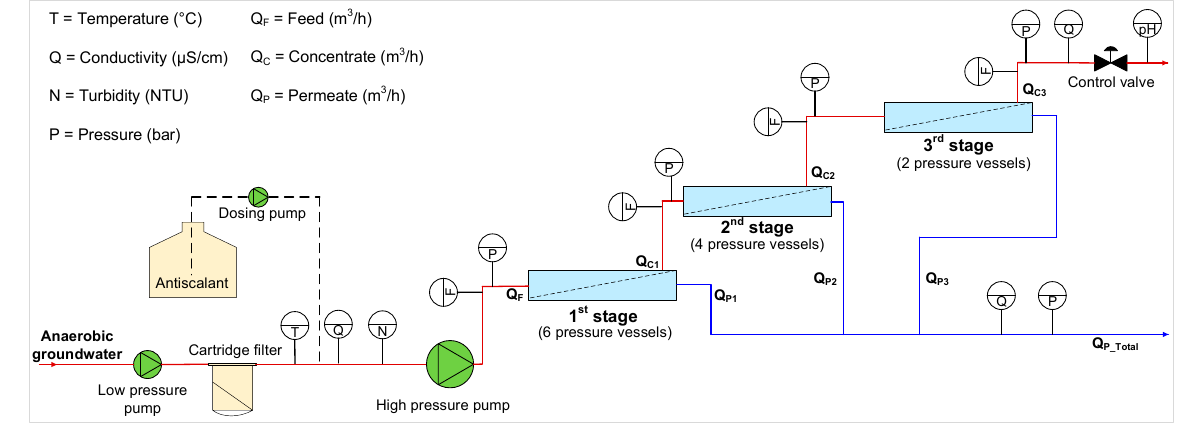
Figure 1. Schematic representation of the RO pilot installation in Kamerik [36]. Table 3. RO operation without antiscalant (to identify scalants that cause permeability decline), and with antiscalants (to increase RO recovery to 85%).